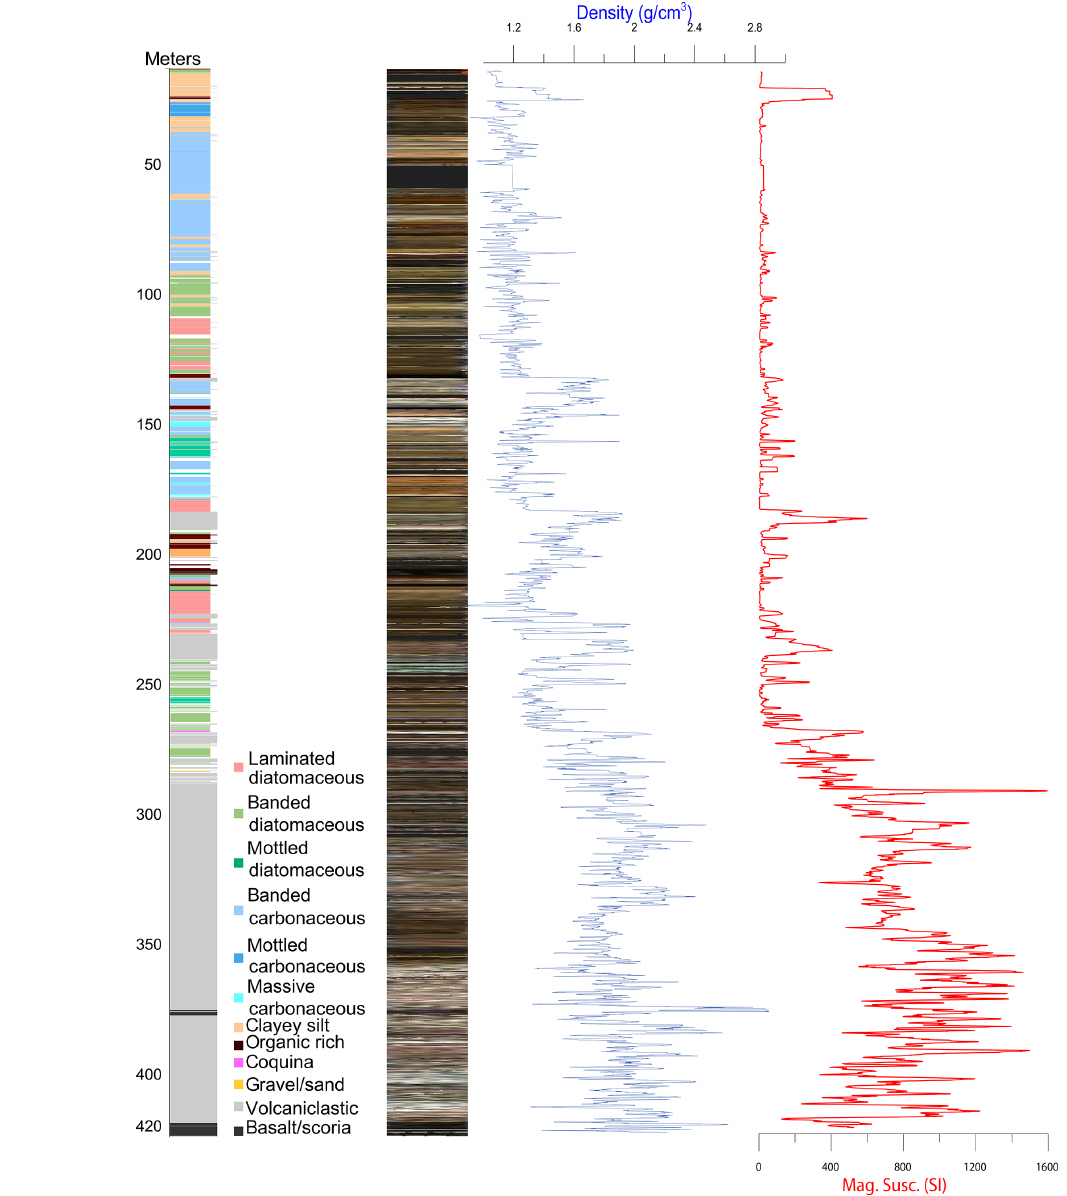
Figure 8. Selected results from the initial core description of MEXI-CHA16-1A, including lithology, color, density, and magnetic suscepti- bility. The broad shifts from diatomaceous to carbonaceous sediments are possibly associated with glacial–interglacial cycles, with relatively wetter times associated with Northern Hemisphere